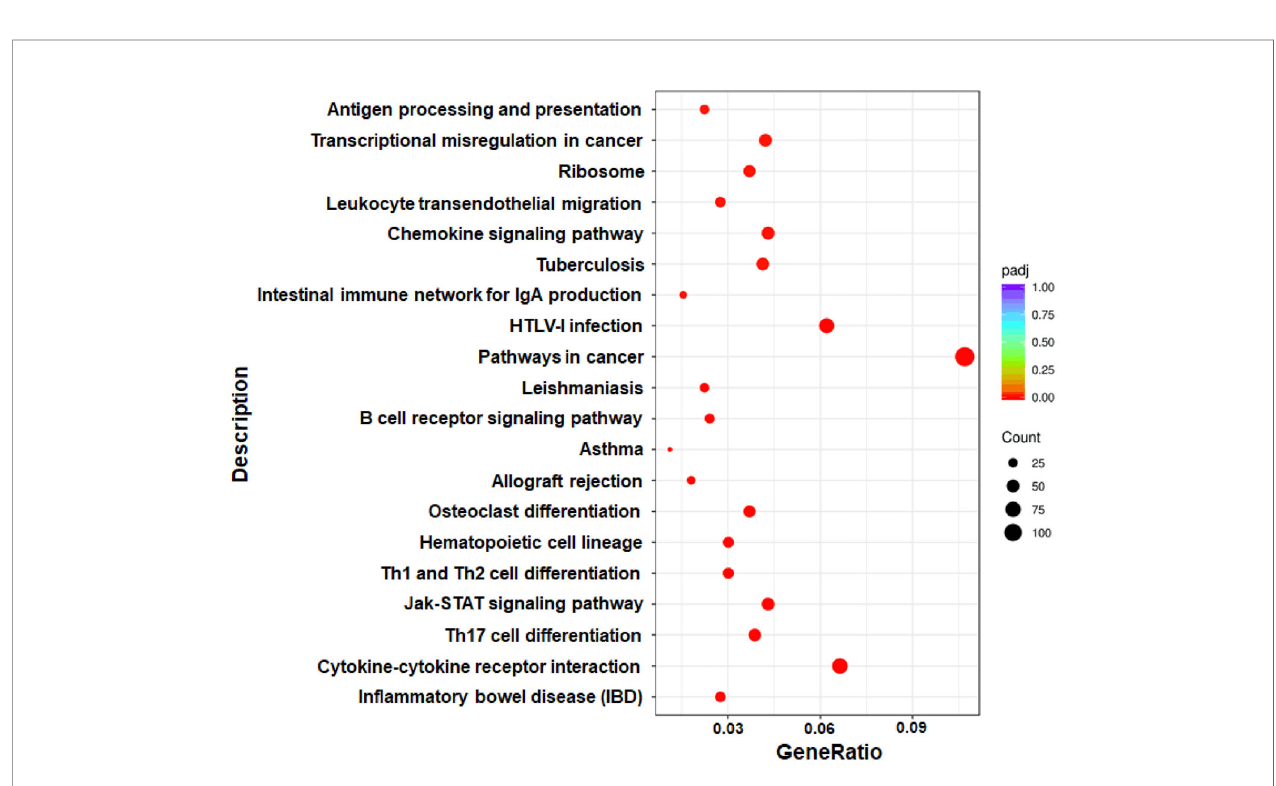
FIGURE 4 | Scatter plot of DEGs enriched in KEGG pathways (KO vs WT). The GeneRatio represents the ratio of the number of DEGs to the number of all the unigenes in the pathway; the padj value represents the corrected